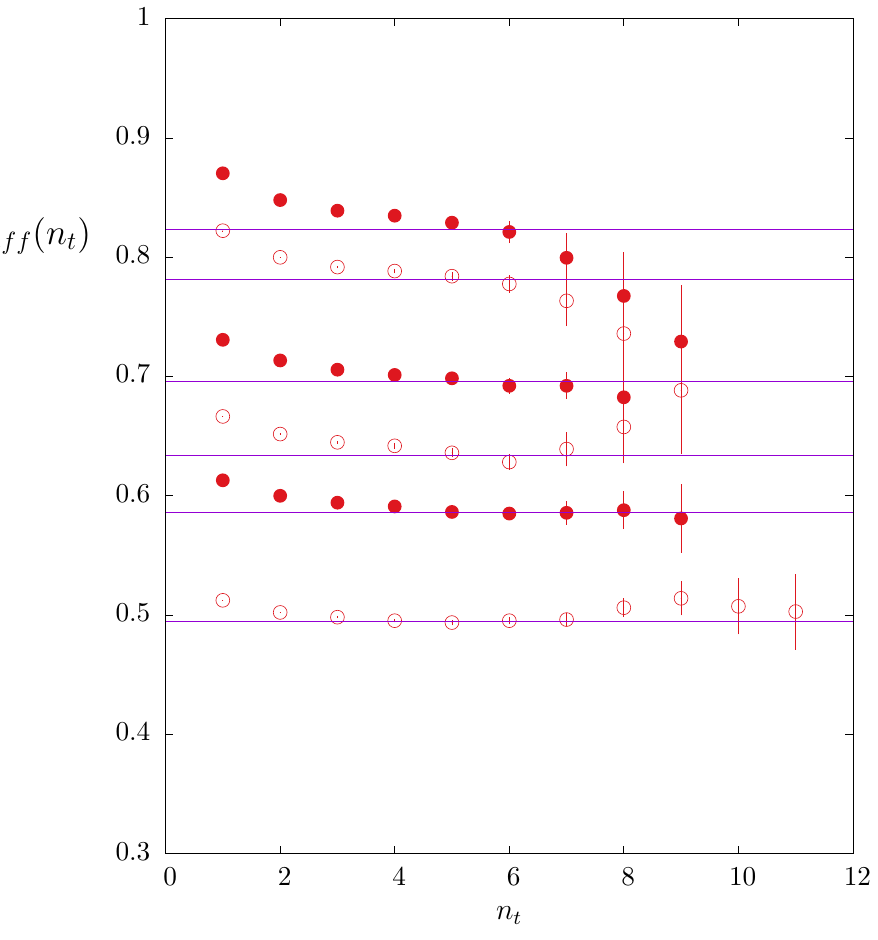
p (cid:27) (cid:24) 4 : 4,